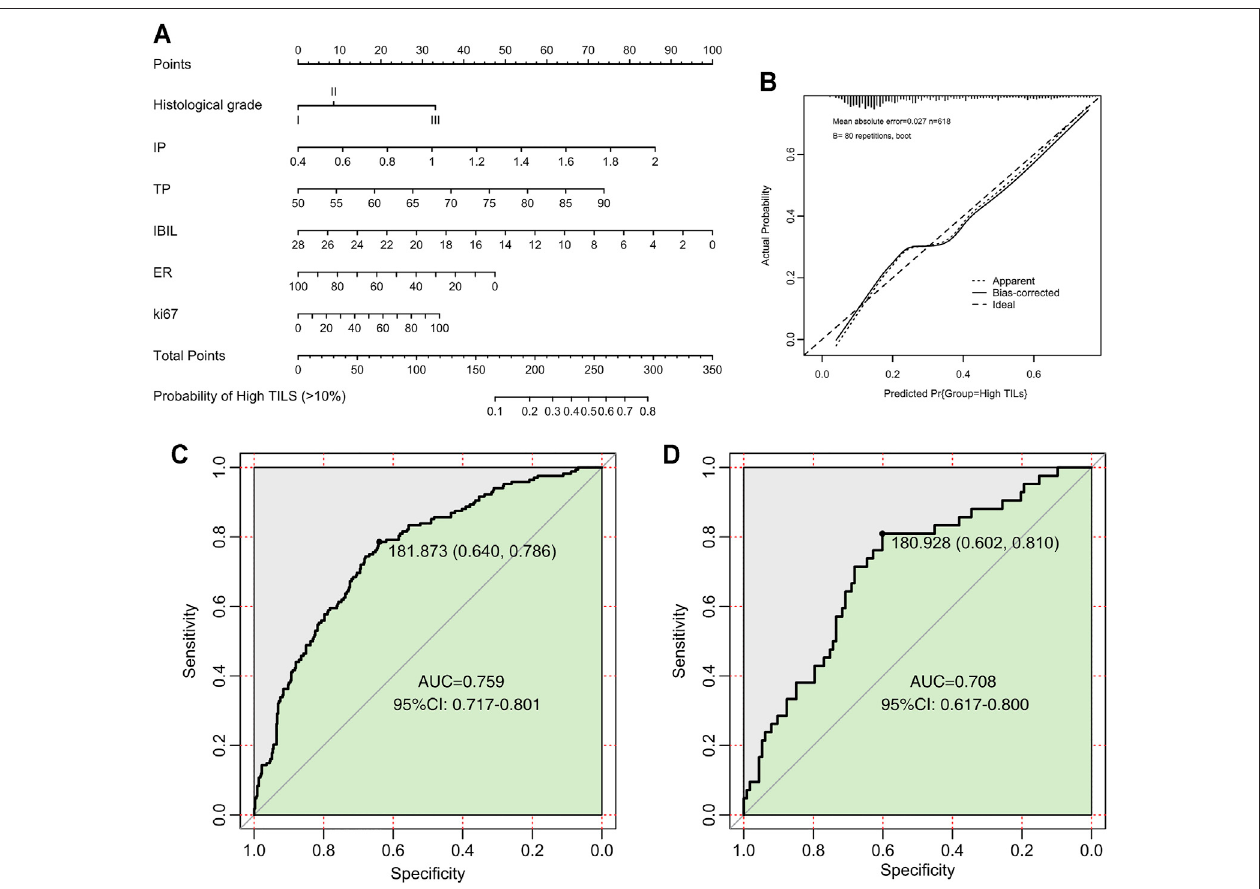
FIGURE 3 | Nomogram, calibration curves, and ROC curve analysis for predicting the density of TILs in patients with breast cancer. (A) Prediction nomogram for TILs in breast cancer patients. (B) Calibration curves for predicting the density of TILs. (C) ROC curves for the TILs prediction nomogram in the internal training set. (D) ROC curves for the TILs prediction nomogram in the validation set. All the points assigned on the top point scales for various factors were summed to generate a total point score. The total score was projected on the bottom scales to determine the probability of high-density TILs in an individual. The nomogram-predicted frequency ofhigh TILdensity wasplotted on the x -axis, and theactualobserved frequency ofhigh Tcell density wasplottedon the y -axis. The AUCwascalculated, and its 95% CI was estimated by bootstrapping. TILs, tumor-in fi ltrating lymphocytes; ROC, receiver operating characteristic; CI, con fi dence interval.